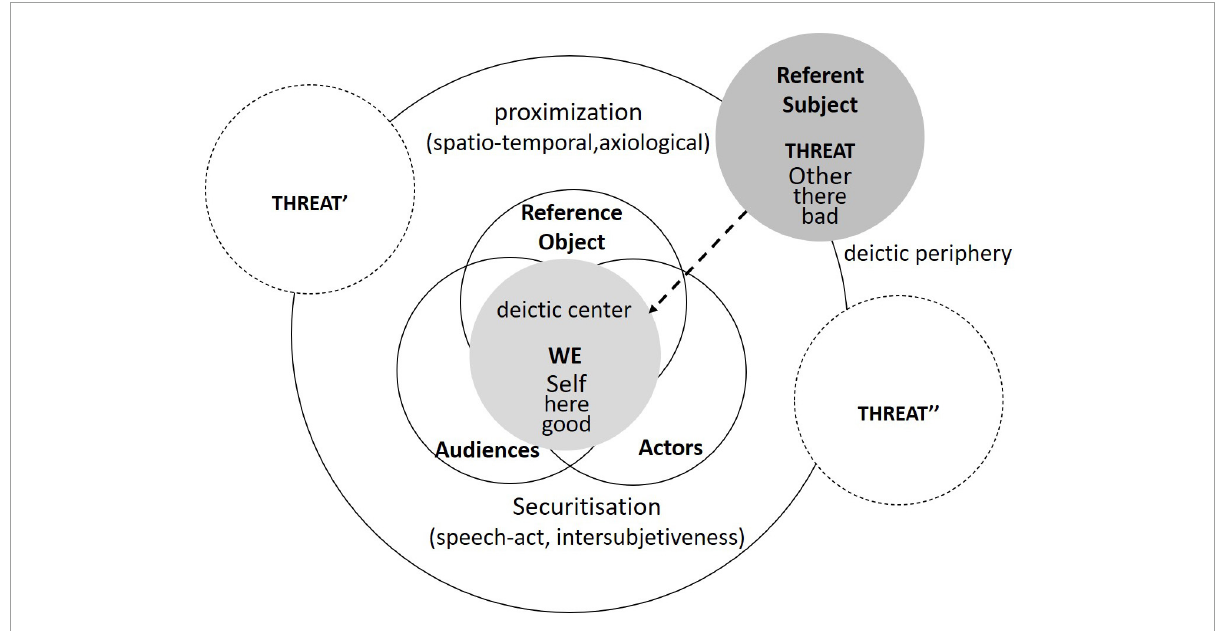
FIGURE2 A discourse-based analytic